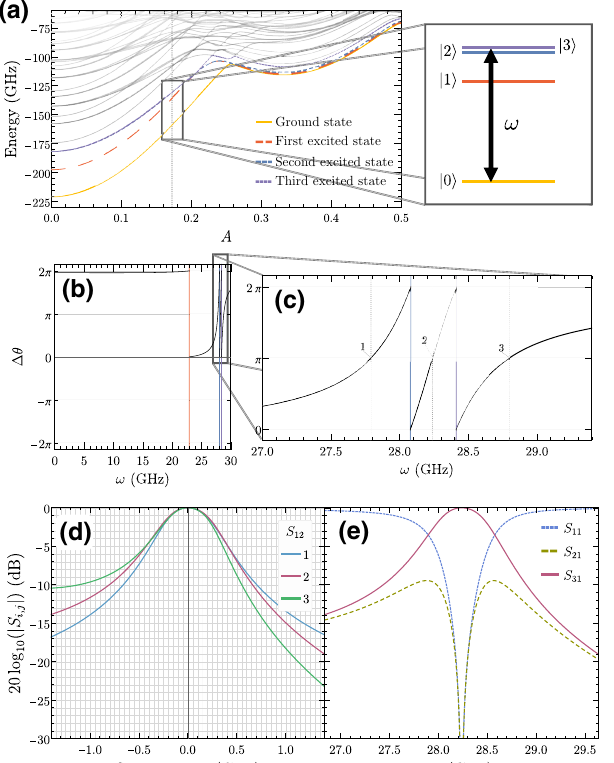
FIG. 7. (a) The energy-level structure at A = 0.1725 in region 1 and the relevant transition from the ground state. The phase difference (cid:20)θ as a function of driving frequency ω is shown in (b),(c), where dashed vertical lines indicate the nonrecipro- cal target frequencies, enumerated for future reference. The red, blue, and purple vertical lines indicate the first, second, and third excited energies, respectively, for the central circuit. The parame- ters for these plots are as in Fig. 4, except for A = 0.1725. For the enumerated nonreciprocal points in (c), we show (d) the trans- mission bandwidth and (e) the signal circulation. The parameters are as in (b),(c), where the procedure for determining g , κ , and ω R is identical to that described in Sec. IV A.